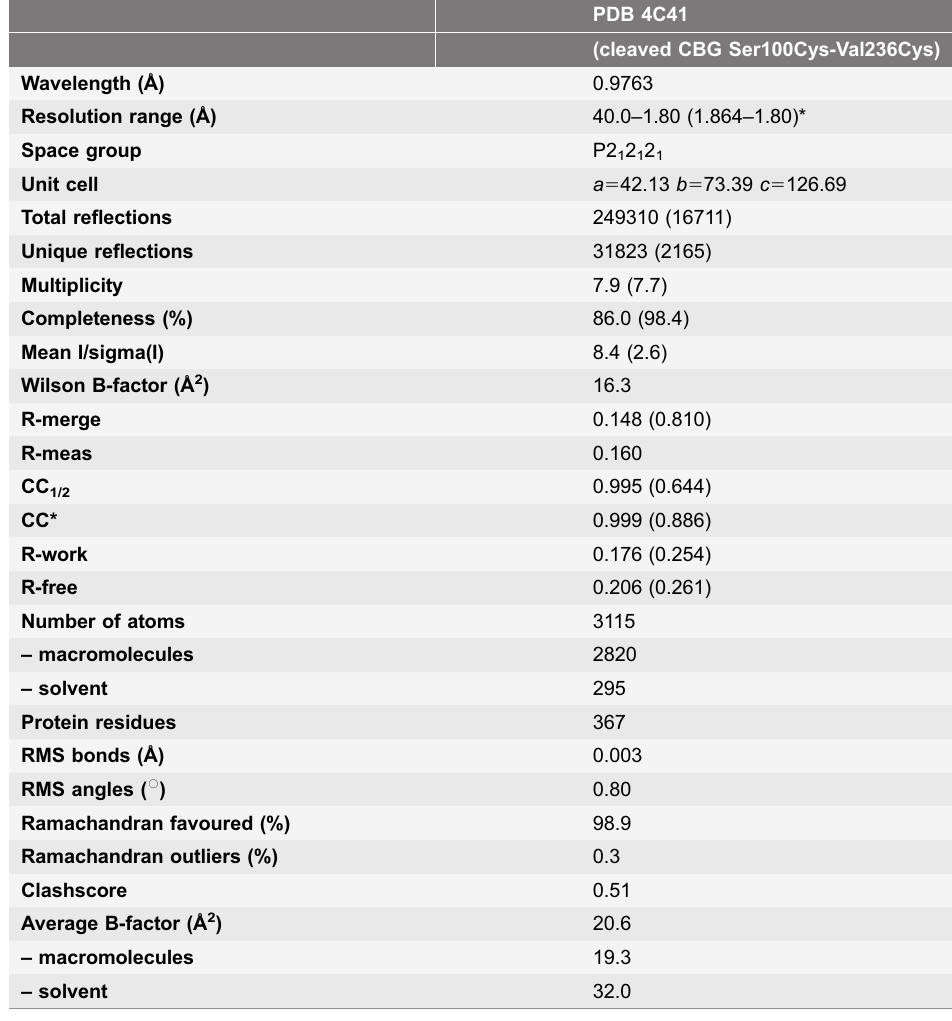
Table 1. Crystallographic